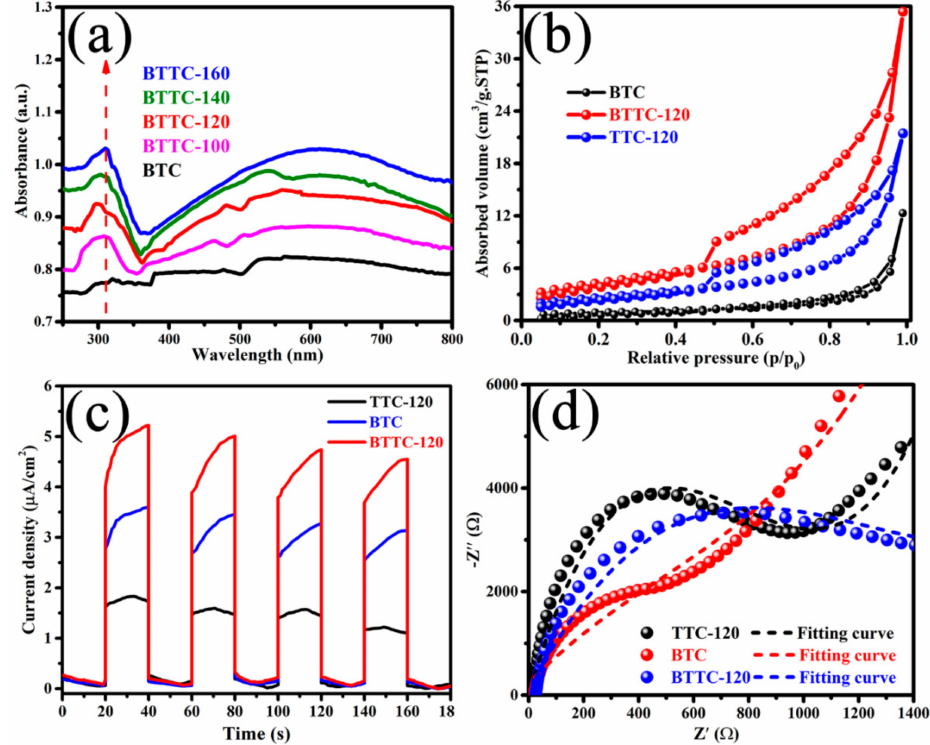
Figure 4. ( a ) UV-vis di ff use reflectance spectra (DRS) of as-synthesized BTC and BTTC-x (x = 100, 120, 140, and 160 ◦ C, respectively); ( b ) N 2 adsorption-desorption isotherms of the as-prepared BTC, TTC-120, and BTTC-120 powders; ( c ) Photocurrent response and ( d ) electrochemical impedance spectra of BTC, TTC-120, and